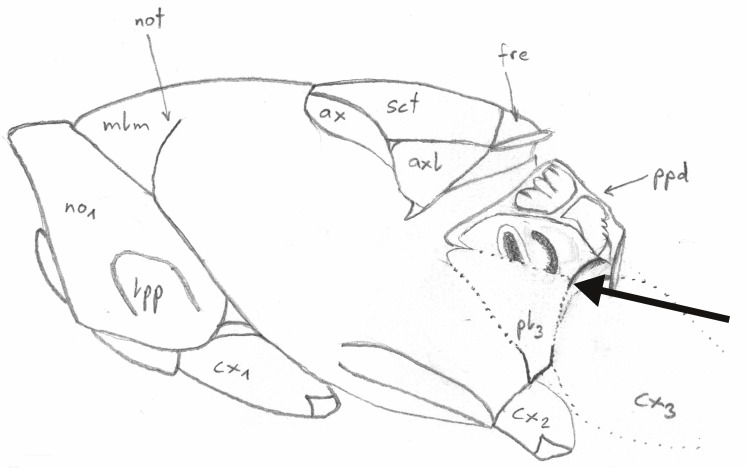
Inclination sharp.